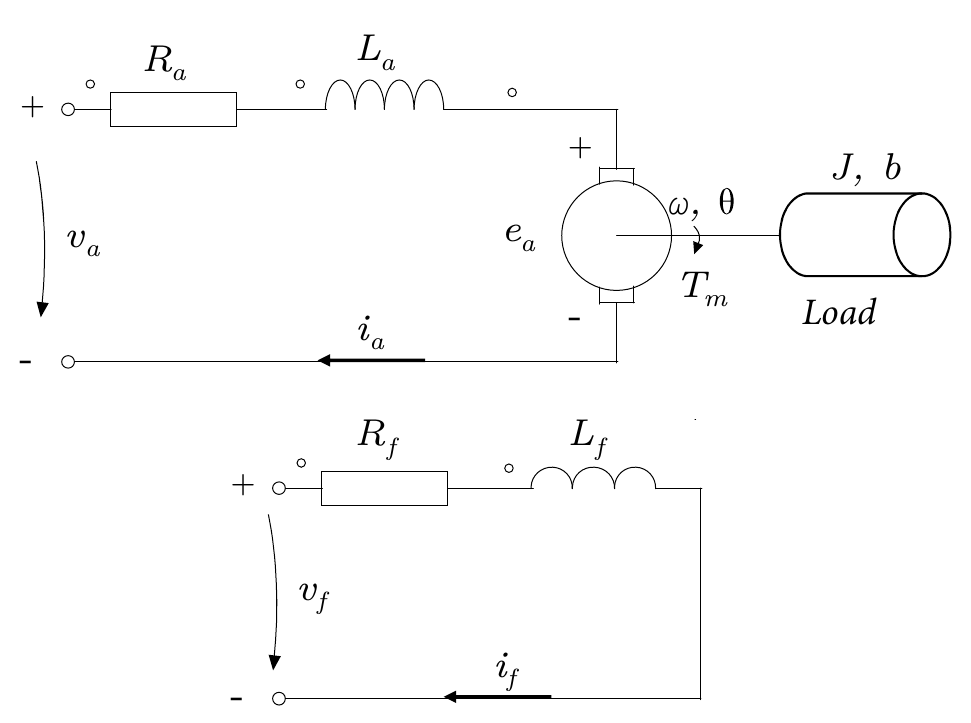
Figure 6. Internal wiring of the motor from an electronic point of